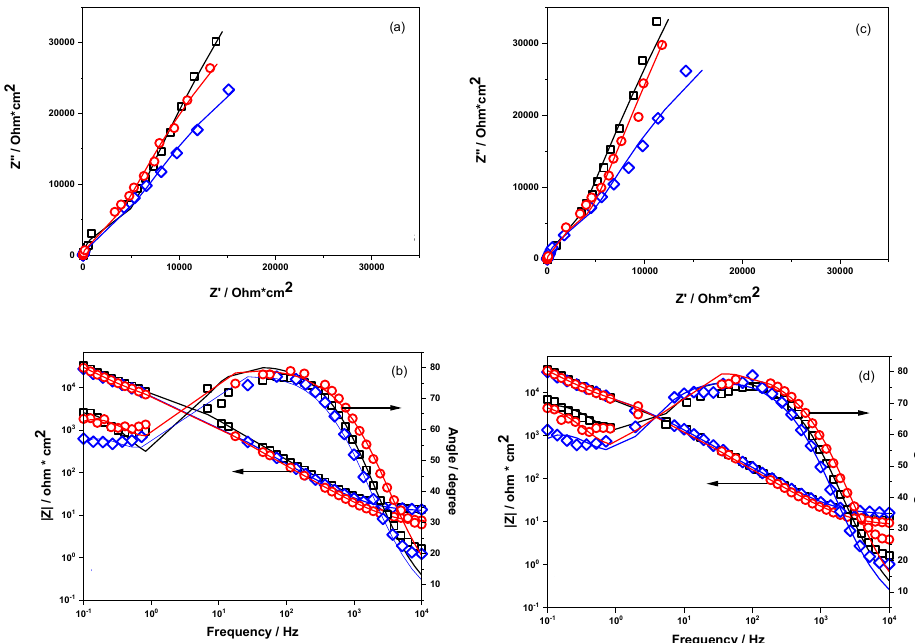
Figure 6. Nyquist ( a , c ) and Bode ( b , d ) impedance spectra recorded for HAP-Chit/Ti ( ), HAP_4AP_25-Chit/Ti ( ), and Si–HAP_4AP_25-Chit/Ti ( µ ) coatings exposed to 5 mM K 3 [Fe(CN)] 6 /K 4 [Fe(CN)] 6 + 0.1 M KCl ( a , b ) and SBF ( c , d ) solutions of pH 7. The line is the fitting curve of the experimental data using the electric equivalent circuit model R s (Q coat R coat ) (Q ct R ct ). The R ct is a quantitative parameter, which indicates the hindering of the electron transfer process through the composite matrix [59]. Table 2. EIS parameters of HAP ‐ Chit/Ti, HAP_4AP_25 ‐ Chit/Ti, and Si–HAP_4AP_25 ‐ Chit/Ti coatings.